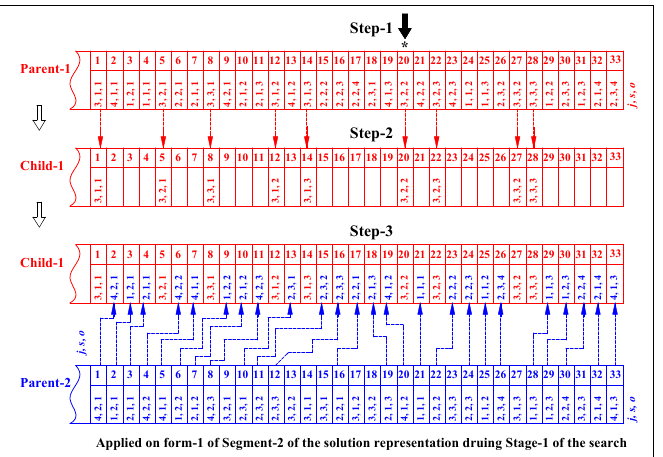
Applied on form-1 of Segment-2 of the solution representation druing Stage-1 of the search Figure 6. Illustration of the JLGSC crossover operator (an asterisk * in Step-1 denotes the location of an arbitrarily selected